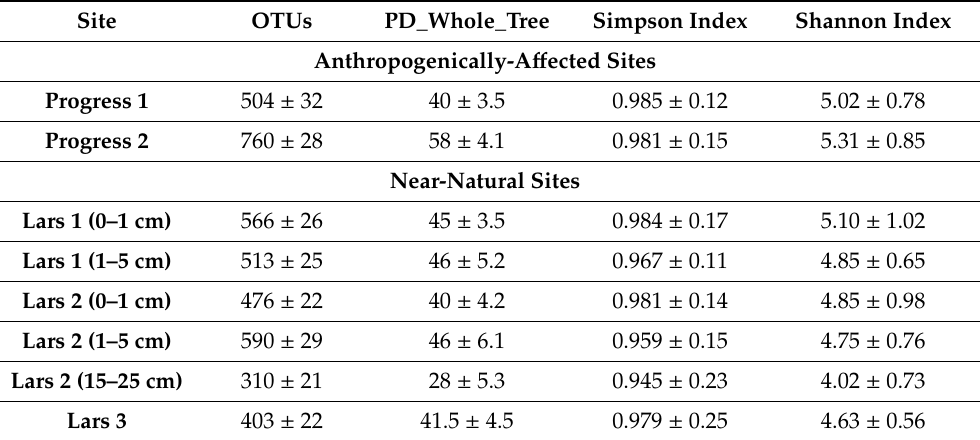
Figure 3. Taxonomic composition at phylum level of soil microbial communities of investigated soil samples. Table 4. Alpha-diversity parameters of investigated soils